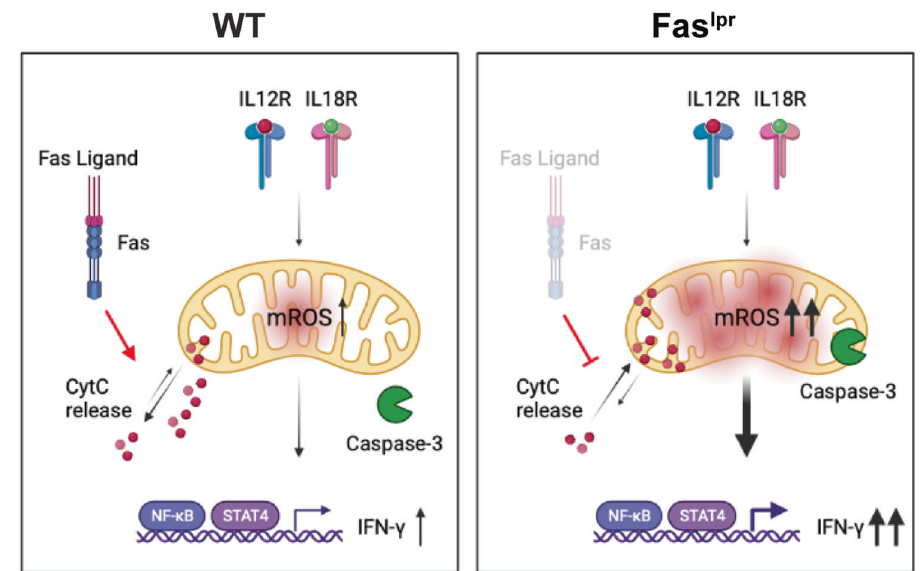
Fig. 8 Model for Fas/FasL regulating mROS and IFN- γ production after IL-12/IL-18 stimulation. Left , IL-12/IL-18 stimulation triggers mitochondria activation and mROS production, which activate the pathway leading to IFN- γ expression. Fas/FasL interaction leads to cytochrome C release, which controls mitochondrial activity and mROS production [39] and, consequently, IFN- γ . Caspase-3 is located outside of mitochondria [58], but there is no apoptosis induction in response to IL-12/IL-18. Right , In absence of Fas, cytochrome C is retained in mitochondria and mROS production is increased. Fas de fi ciency provokes caspase-3 translocation to mitochondria after IL-12/IL- 18 stimulation, which might further increase mROS production [54]. Overall, increased mROS production results in IFN- γ hyperproduction in absence of Fas/FasL